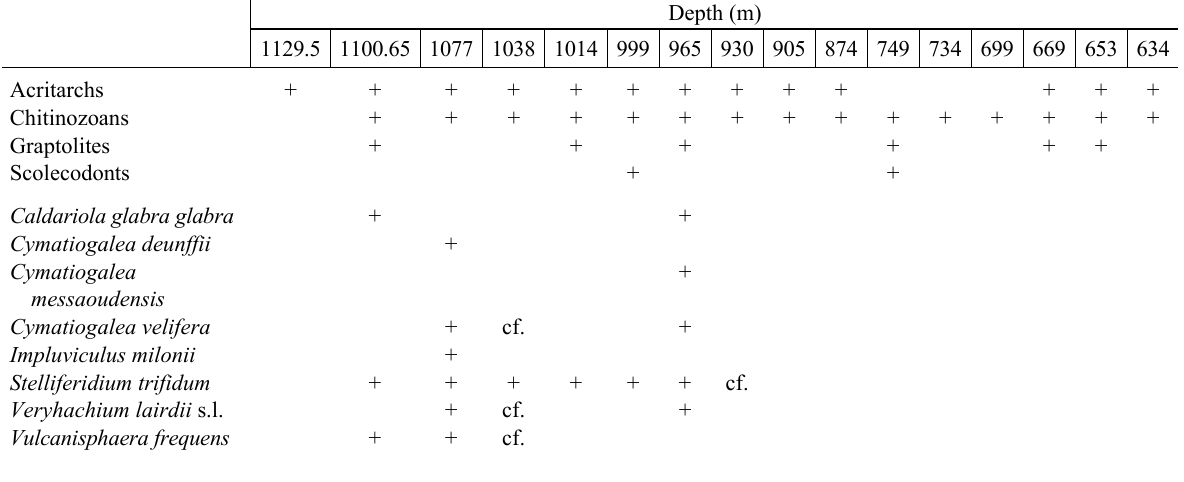
Table 1. Occurrences of palynomorph groups and selected acritarch species in the Fezouata formations of borehole